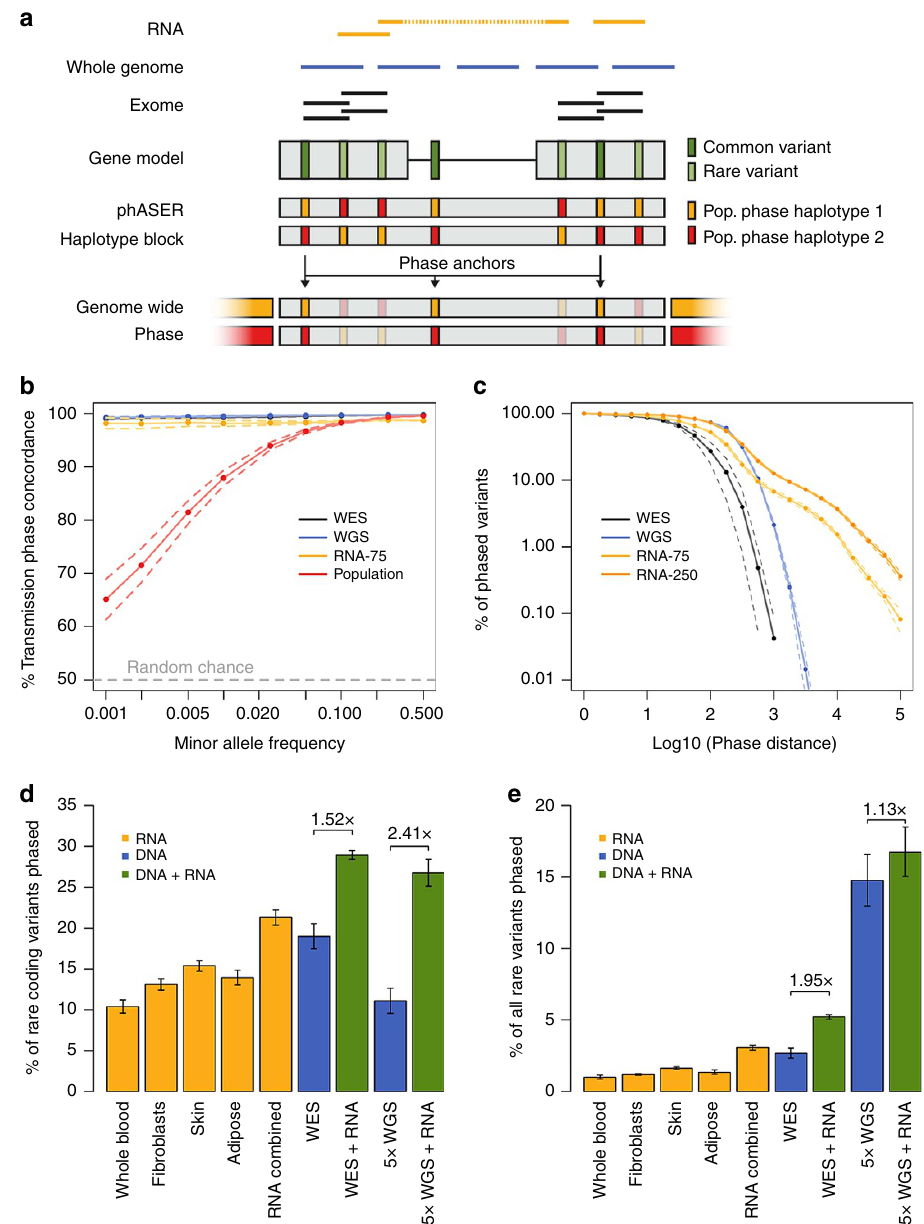
Figure 1 | Read backed haplotype phasing that incorporates RNA-seq using phASER. ( a ) phASER produces accurate variant phasing through the use of combined DNA and RNA read backed phasing integrated with population phasing. Due to splicing, RNA-seq reads often span exons and UTRs, allowing read backed phasing over long ranges, while high coverage exome and whole genome sequencing can phase close proximity variants. For each group of read connected variants a local haplotype is produced by testing all possible phase configurations, and selecting the configuration with the most support (Supplementary Fig. 1). Local haplotype blocks can be phased relative to one another when population data is available by anchoring the phase to common variants, where the population phase is likely correct. ( b ) Concordance of read backed phasing across sequencing assays and population phasing with phasing by transmission using the Illumina NA12878 Platinum Genome as a function of variant minor allele frequency. Concordance is defined per variant as the percentage of variant—variant phase events that are correct as compared with the known transmission phase. ( c ) Percentage of phased variants that can be phased at greater than or equal to increasing genomic distances using WES, WGS, paired-end 75 and 250 RNA-seq data in two tissues (whole blood and LCLs) of four GTEx individuals. Solid lines represent the means, and dotted lines the standard error. ( d , e ) Contribution of read backed phasing at rare coding (MAF r 1%) variants ( d ) and all rare variants ( e ) across sequencing assays and GTEx RNA-seq tissue types for four individuals. Values shown are the mean percentage of rare variants within an individual that can be assigned a genome wide phase using phase anchoring. Error bars show the standard error. The fold increase in the number of rare variants that can be phased using DNA-seq with the addition of combined RNA-seq libraries is diversity 13 (Supplementary Fig. 5c), but not total read depth (Supplementary Fig. 5d).